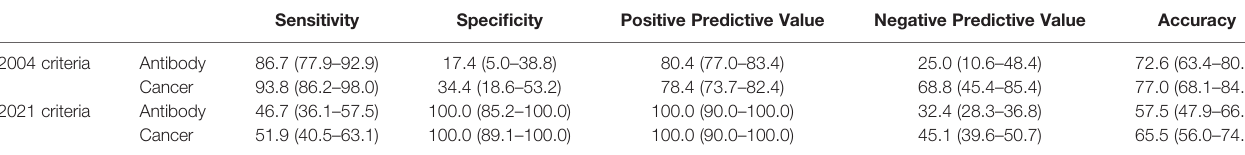
TABLE 4 | Diagnostic performance of antibody and cancer for a de fi nite diagnosis of PNS by the 2